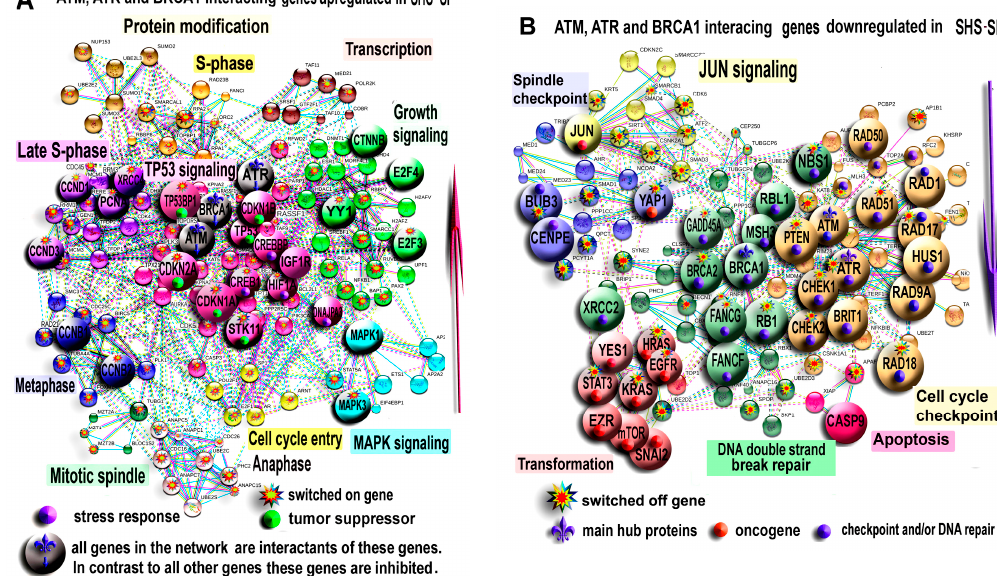
Figure 6. Protein-protein interaction network for ATM, ATR and BRCA1 interacting genes demonstrating expression difference above twofold between control eMSC and SHS-SP. The network for induced genes ( A ) and for inhibited genes ( B ). Large symbols show genes with above fivefold expression difference. Symbols marked with asterisks show switched-on and switched-off genes. The networks were constructed using STRING server (evidence view option) with interaction confidence above 0.5. Clustering was performed by MCL algorithm. The clusters are titled according to GO biological processes and KEGG molecular pathways enriched in cluster-comprising genes with q < 10 − 4 . The network at ( A ) illustrates that SHS-SP show long-term induction of TP53 signaling and signaling related to first stages of cell cycle. The network at ( B ) indicates that SHS-SP downregulate signaling related to DNA repair, DNA damage checkpoint, spindle checkpoints and transformation.